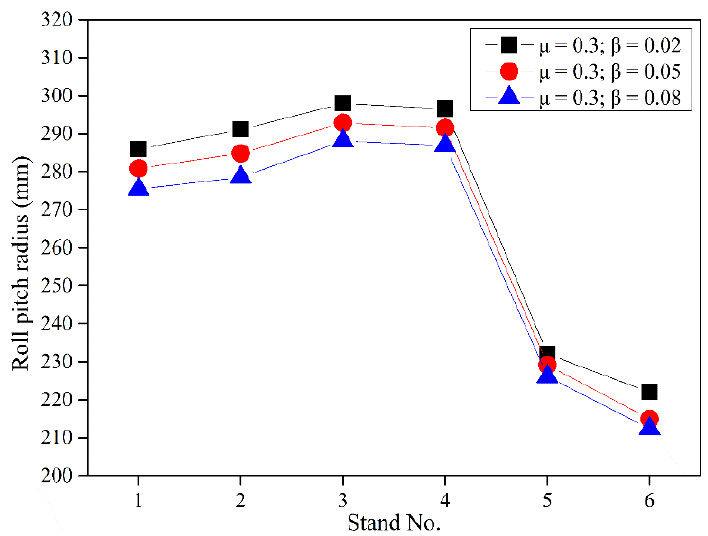
Figure 13. Calculated roll pitch radius with various tube-mandrel frictional coefficients.